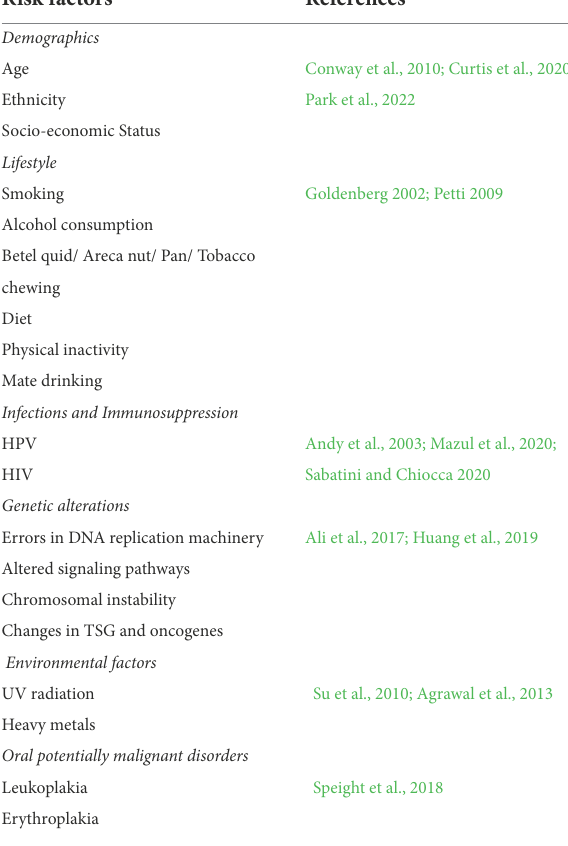
TABLE 1 Summarizing the risk factors related to head and neck cancer